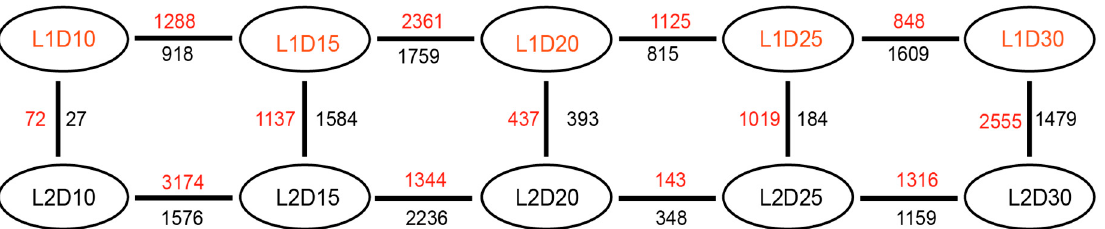
Figure 2. Vertical of L1 relative to L2 and horizontal comparisons of genes that showed differential expression levels between the two lines at the same developmental stage and between different stages of an individual line. Red numbers represent upregulated genes; black numbers indicate down-regulated genes. The differentially expressed genes were identified by the criteria FPKM > 0.5, |log 2 (FC)| > 1. Table 1. Fragments per kilobase of exon per million reads (FPKMs) and functional categories of genes significantly up-regulated in L1 on